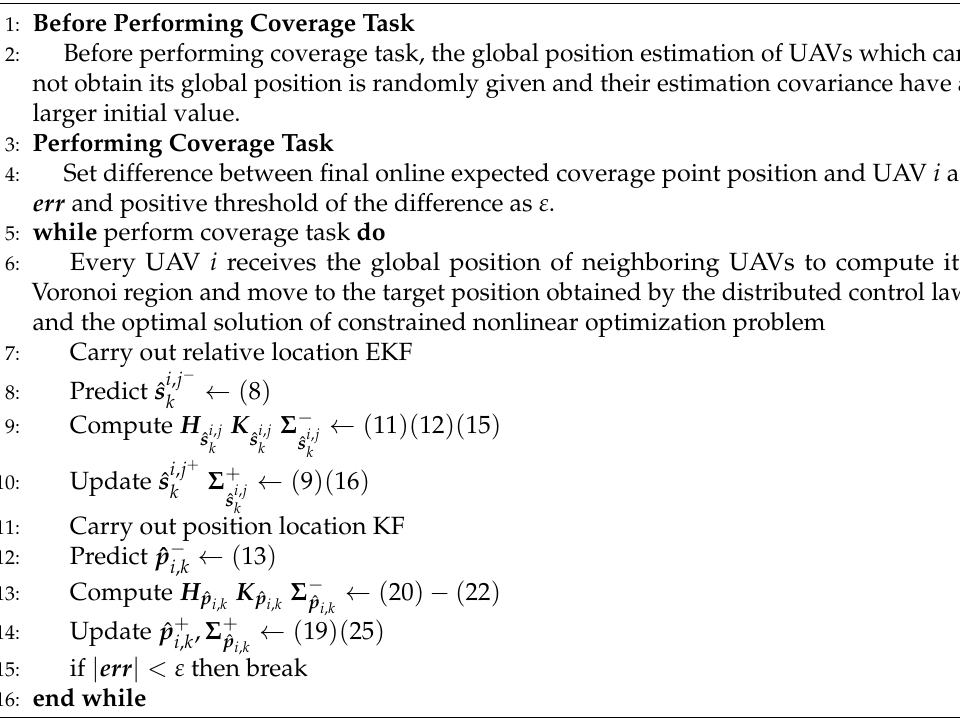
Algorithm 1 Area coverage placement algorithm based on relative